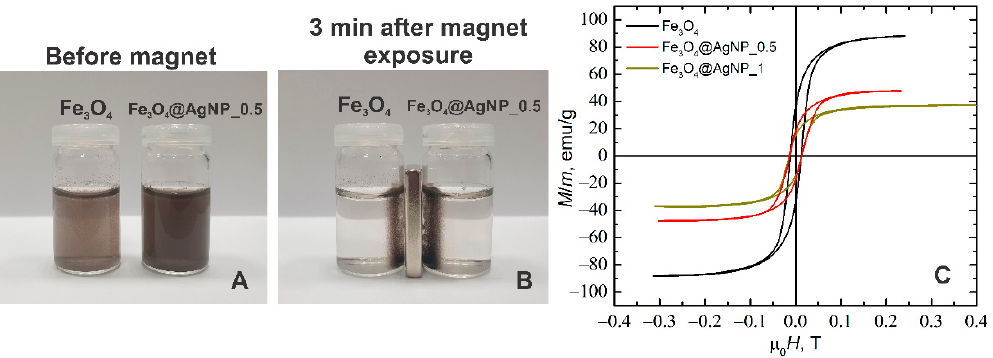
Figure 5. Solutions of magnetite and magnetite decorated with silver NPs ( A ) just prepared and ( B ) in 3 min after exposure to a permanent magnet; ( C ) Hysteresis loop of the magnetite (black), and magnetite decorated with silver nanoparticles: Fe 3 O 4 @AgNP_0.5 (red) and Fe 3 O 4 @AgNP_1 (dark yellow);